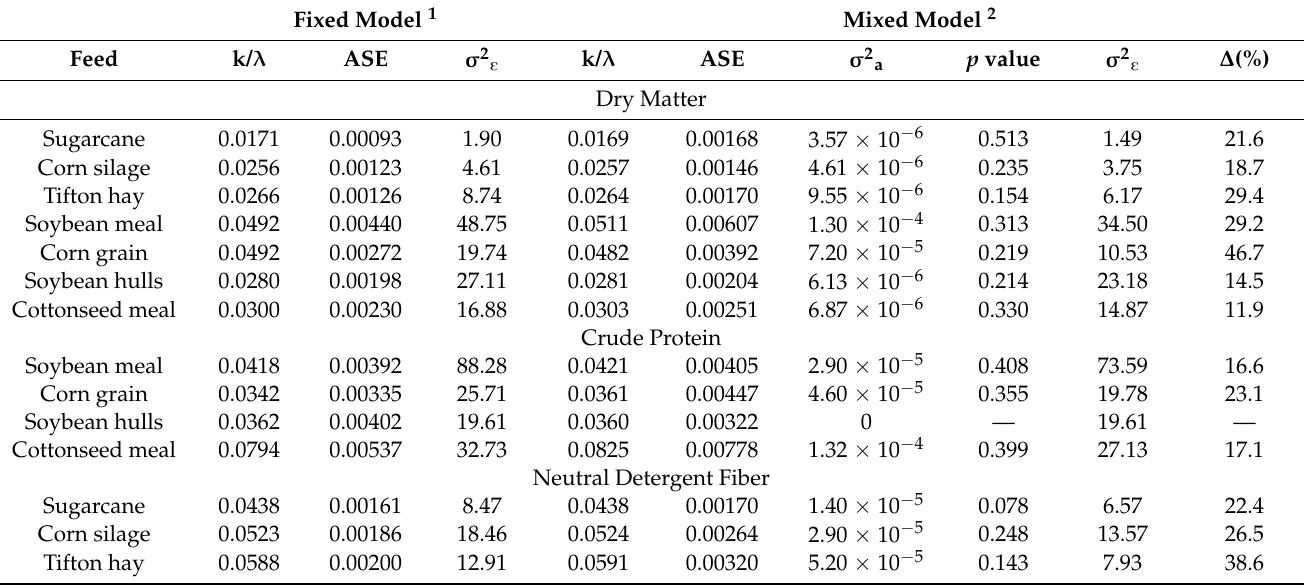
Table 3. Characteristics of estimation process of the parameters associated with degradation rate (k ou λ , h − 1 ) in different feeds and feed components using fixed or mixed modelling